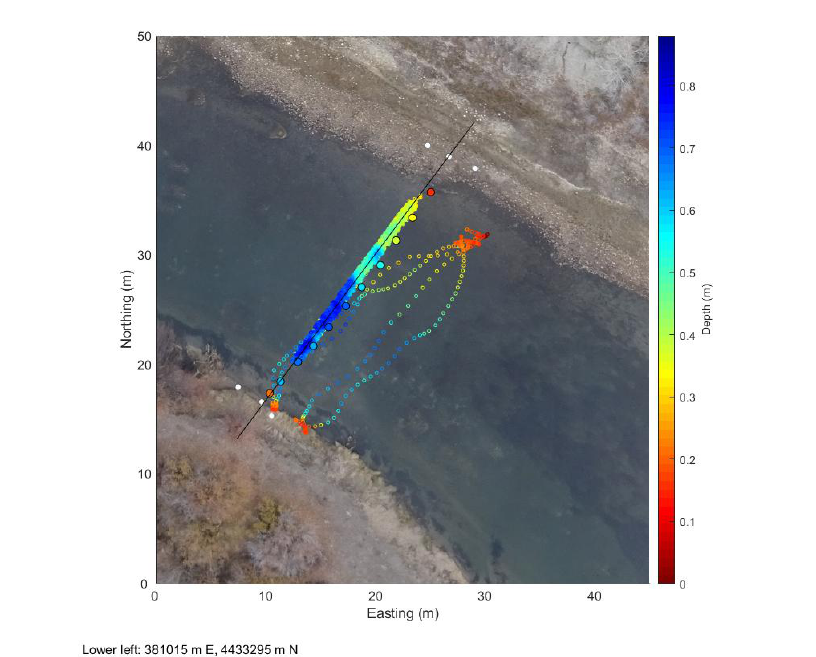
Figure 4. Depths measured by wading (large filled symbols with black circle outlines), ADCP (mid-size open symbols with colored circle outlines), and lidar (small filled symbols) collected at cross section